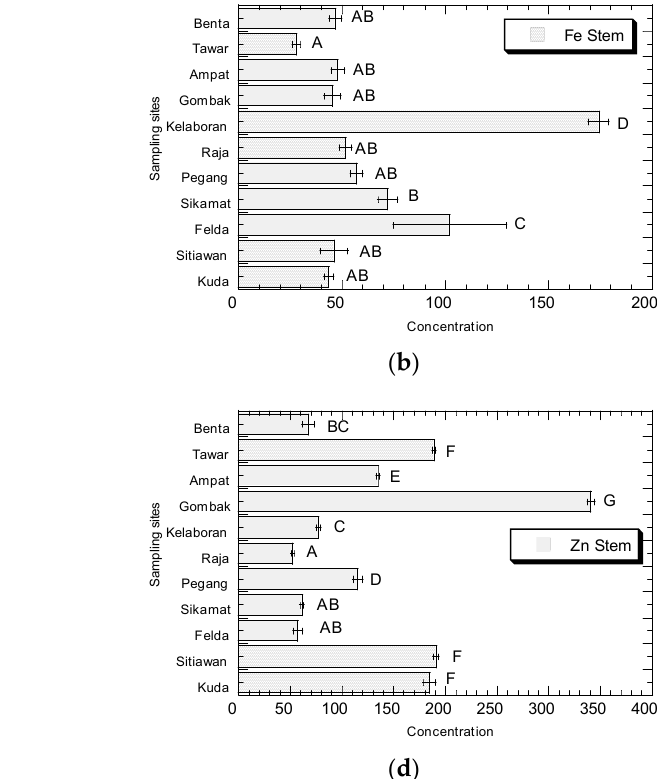
Figure 3. Concentrations (mean ± SE, µg/g dry weight) of Cd ( a ), Fe ( b ), Ni ( c ), and Zn ( d ) in the stems of Amaranthus viridis collected from all the sampling sites in Peninsular Malaysia. Metal concentrations sharing a common letter are not significantly different ( p > 0.05) based on the post-hoc test (Student–Newman–Keuls) in the one-way ANOVA analysis.